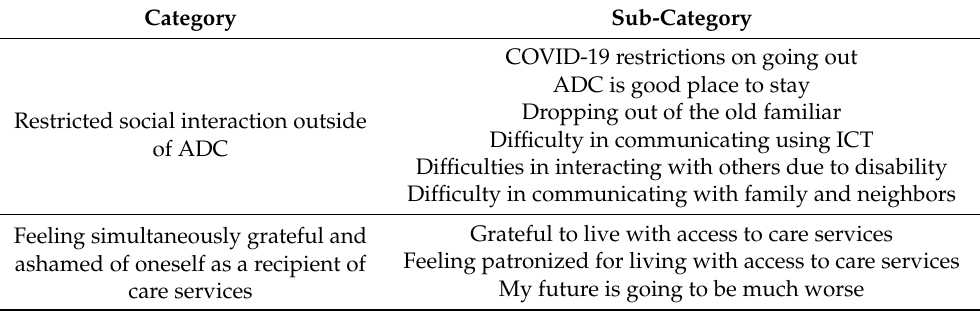
Table 1. Summary of categories of clients’ background. Category Sub-Category COVID-19 restrictions on going out ADC is good place to stay Dropping out of the old familiar Restricted social interaction outside Difficulty in communicating using ICT of ADC Difficulties in interacting with others due to disability Difficulty in communicating with family and